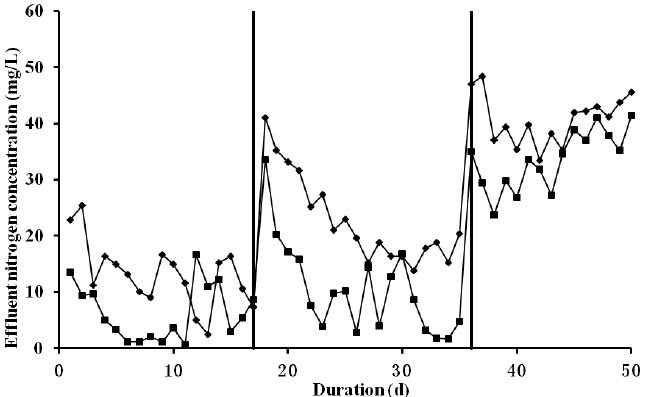
Figure 9. Profiles of ANAMMOX reactor treating the diluted effluents of IASBR ( ■ : NH 4+ -N concen- − -N tration; ♦ : NO 2− -N concentration). concentration; (cid:7) : NO 2